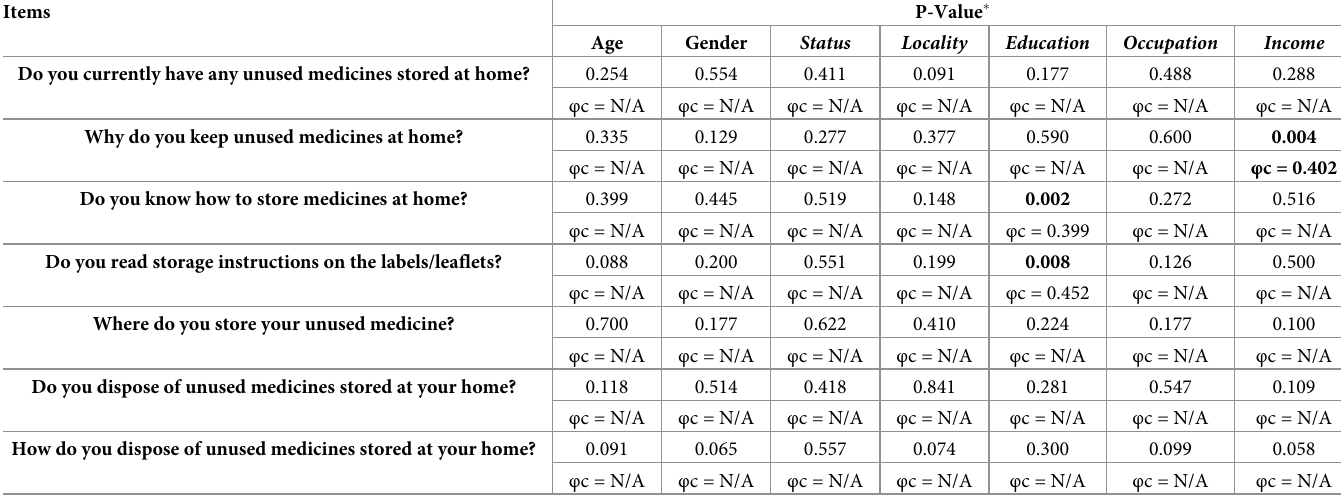
Table 4. Association between storage, and disposal practices of unused medicines and demographics.